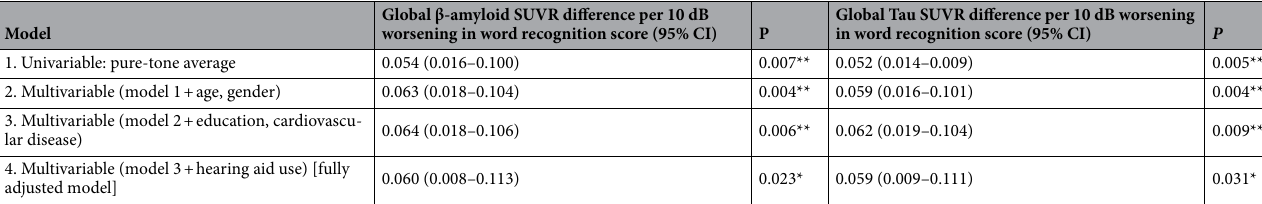
Table 3. Regression models for GLOBAL β-amyloid and Tau SUVR based on word recognition score hearing. SUVR standardized uptake value ratio, CI confidence interval. *Significant, P <